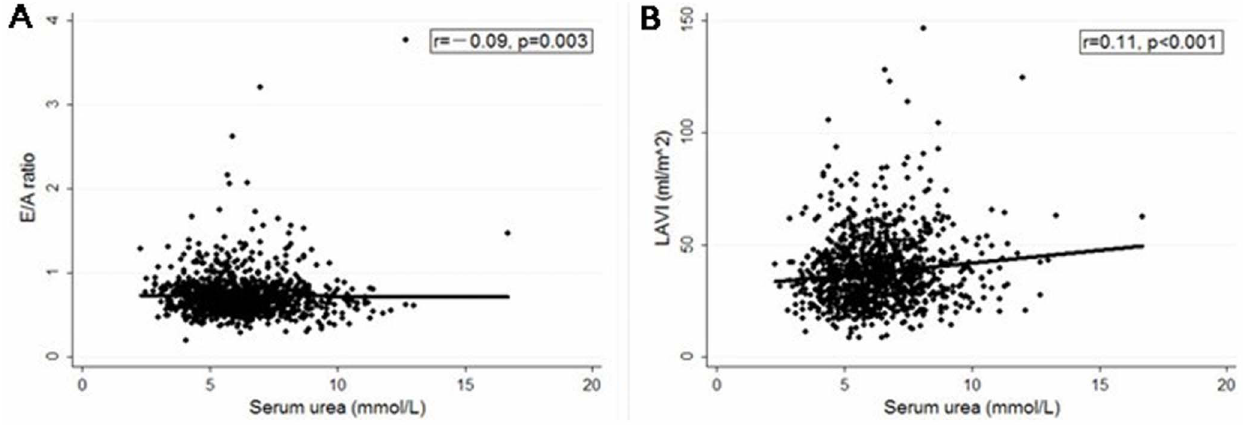
Figure 2. Relationship between serum urea and echocardiographic indexes (E/A and LAVI). A) Serum urea was negatively correlated to E/ A ratio. B ) Serum urea was positively correlated to LAVI. LAVI, left atrial volume index.